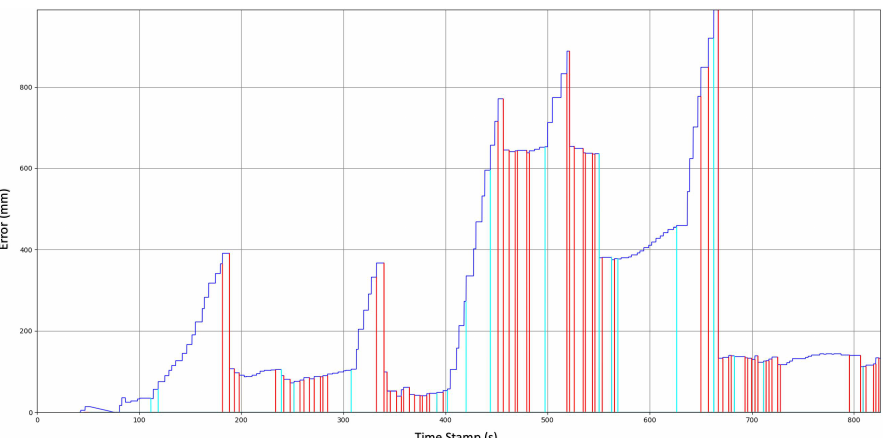
Figure 14. Curve of localization error of submap-based back-end, which shows the ability of fault recovery after tracking is lost and verifies the ability of fault recovery by maintaining tracking. The deep blue curve is the error, the light blue curve is the response of tracking failure and the red curve is the response of loop-closure detection.